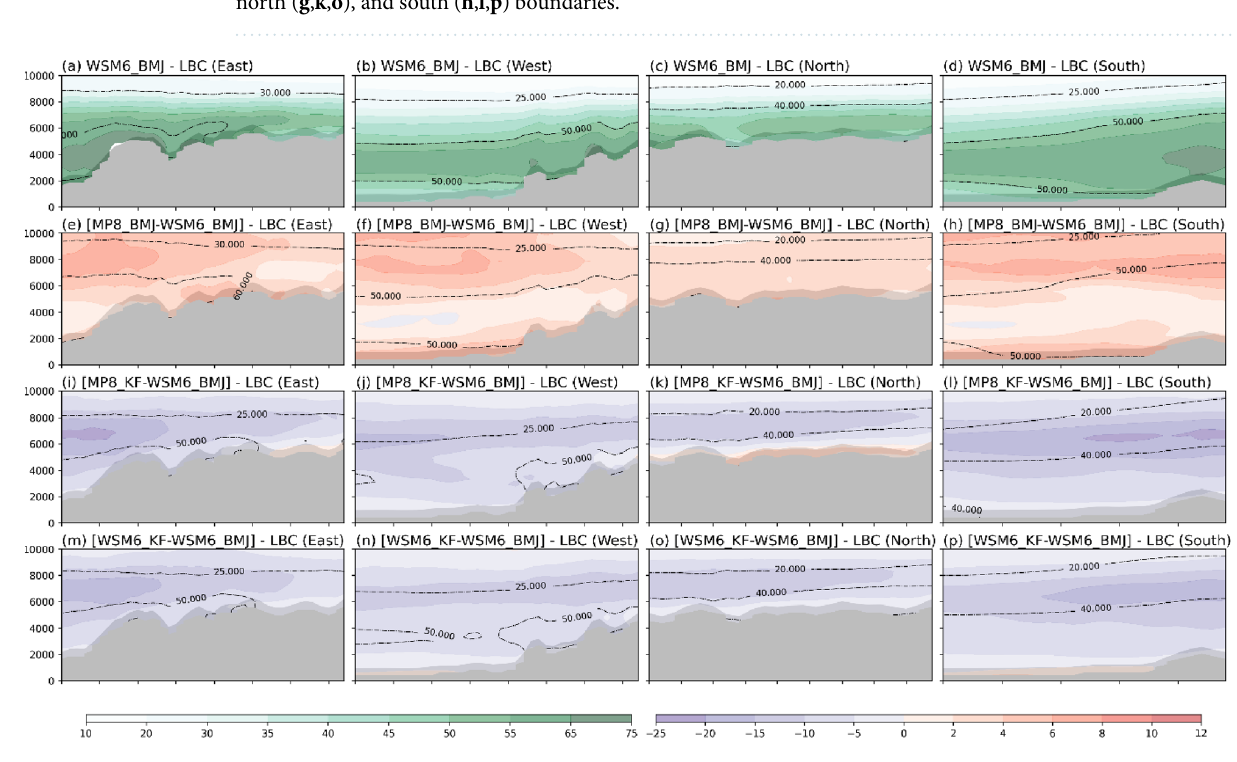
Figure 11. The JJAS-averaged vertical cross section of relative humidity for d02 at d03 boundaries. Gray shaded area shows mountains. ( a – d ) shows actual average mixing ratio for WSM6_BMJ at east ( a ), west ( b ), north ( c ), and south ( d ) boundaries. Further, mixing ratio is shown for MP8_BMJ–WSM6_BMJ ( e – h ), MP8_KF–WSM6_ BMJ ( i – l ), and WSM6_KF–WSM6_BMJ ( m – p ) for vertical cross section of east ( e , i , m ), west ( f , j , n ), north ( g , k , o ), and south ( h , l , p )